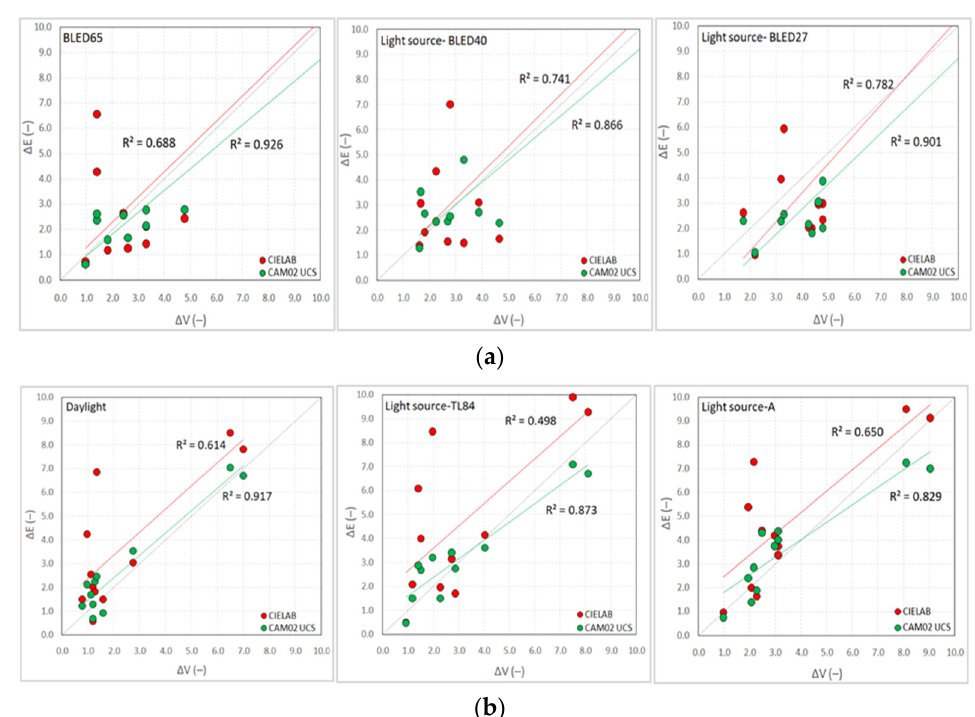
Figure 9. Correlation between visual and formula-based color difference of different light sources. In the figure, BLED65, BLED40, and BLED27 represent the light sources with nominal CCT 6500 K, 4000 K, and 2700 K, respectively for light booth I; and Daylight (Simulator D65), TL84 (Tri-band fluorescent tube), and A (Tungsten lamp) represent the light sources with nominal CCT 6500 K, 4000 K, and 2700 K respectively for light booth II. ( a ) Light booth I, ( b ) Light booth II.